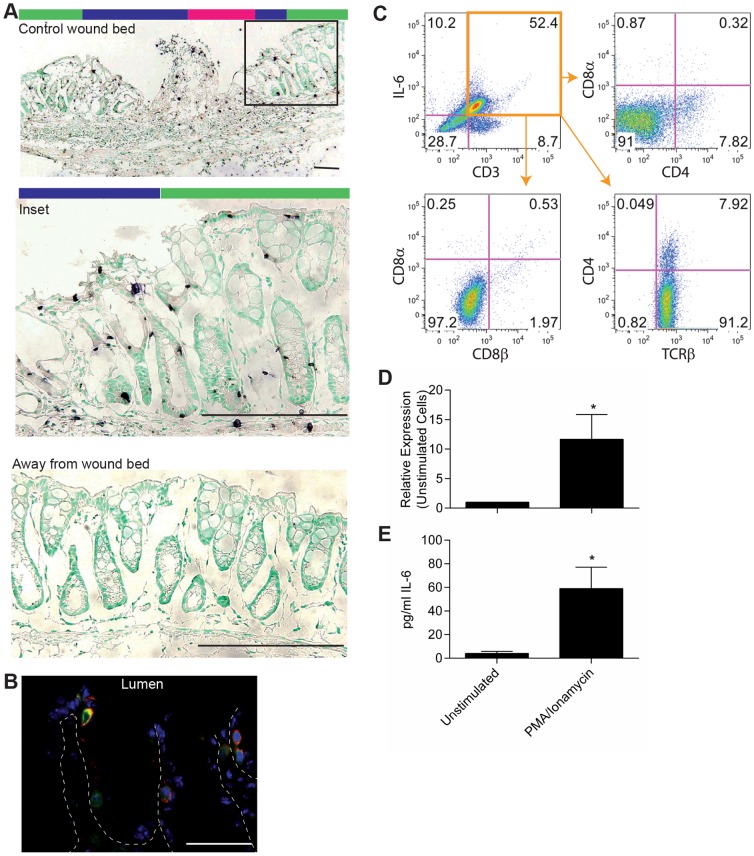
Intraepithelial lymphocytes were a source of IL-6 early after injury.(A) Biopsy of the colon mucosa was performed in WT mice to create small wounds. IL-6 expression in the wound bed and adjacent tissue was evaluated by in situ hybridization one day after biopsy. Representative images were shown. Bars = 200 µm. Colored bars above wound images indicate areas of the wound bed as depicted in Figure 4B. (B) Co-localization by immunofluorescence was performed for IL-6 (red), CD3ε (green), and bis-benzimide (blue) on colon tissue from dnKO mice at day 6 after co-housing. Representative staining was shown at 63X. Bar = 200 µm. (C) Epithelial cells were harvested from dnKO mice on day 6 after co-housing, stained for T cell markers and IL-6, and assessed by flow cytometry. Representative dot plots were shown. (D, E) CD3+ CD4- CD8- IELs were harvested from WT mice and stimulated ex vivo with 10 ng/ml PMA and 1 µg/ml ionamycin for 5 hours. (D) RNA was collected and evaluated by qRT-PCR for IL-6 expression. (E) Culture supernatants were harvested and evaluated for secreted IL-6 by electrochemilluminescence. Data were shown as the average IL-6 expression or protein ± SEM. A paired student's t-test was used to determine significance; *, P<0.05.